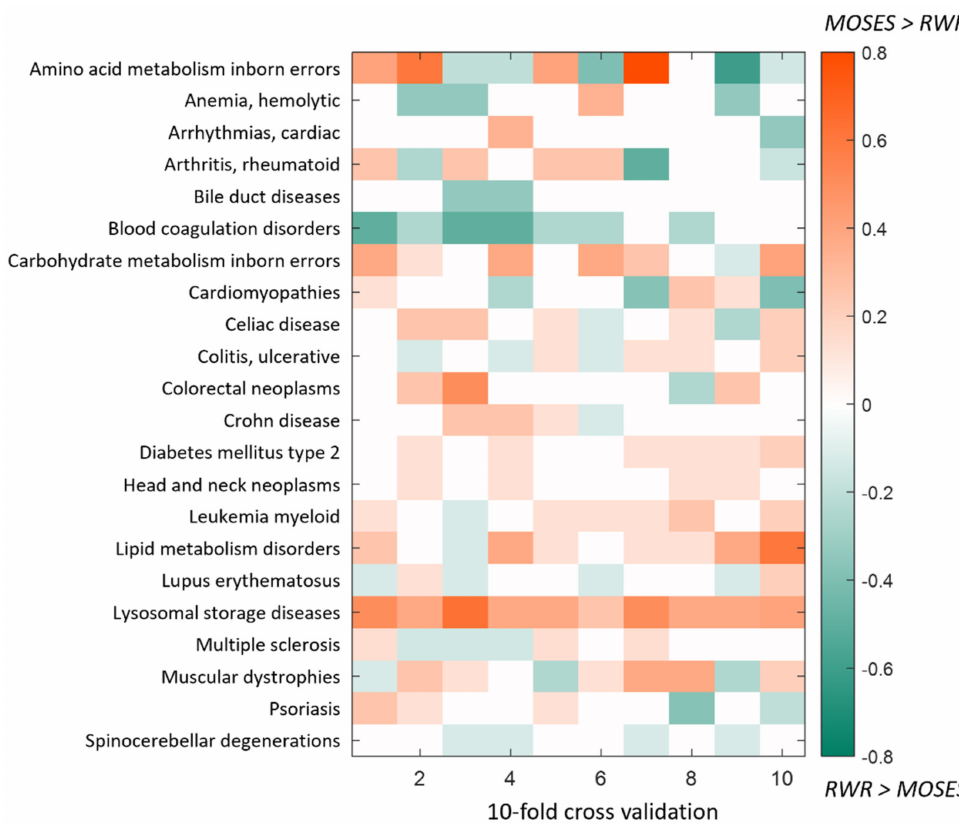
Figure 4. 10-fold cross-validation. Difference between MOSES and RWR performances. The per- formances are computed as the percentage of recovered warm seeds in the test set S P . Rows and columns represent respectively the diseases and the cross-validation iterations. In the case of positive values (orange pixels), MOSES outperforms RWR, while negative values (green pixels) refer to the opposite